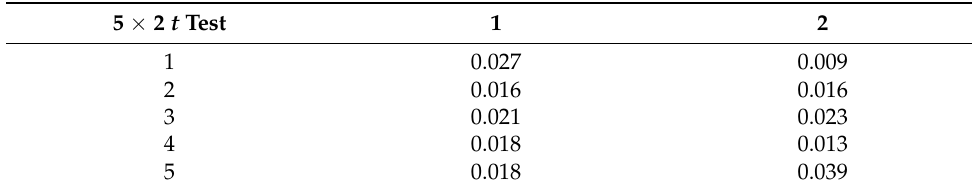
Table 2. Calculated e 1 error values of pump wear condition classification for the full model using 56 signal features.